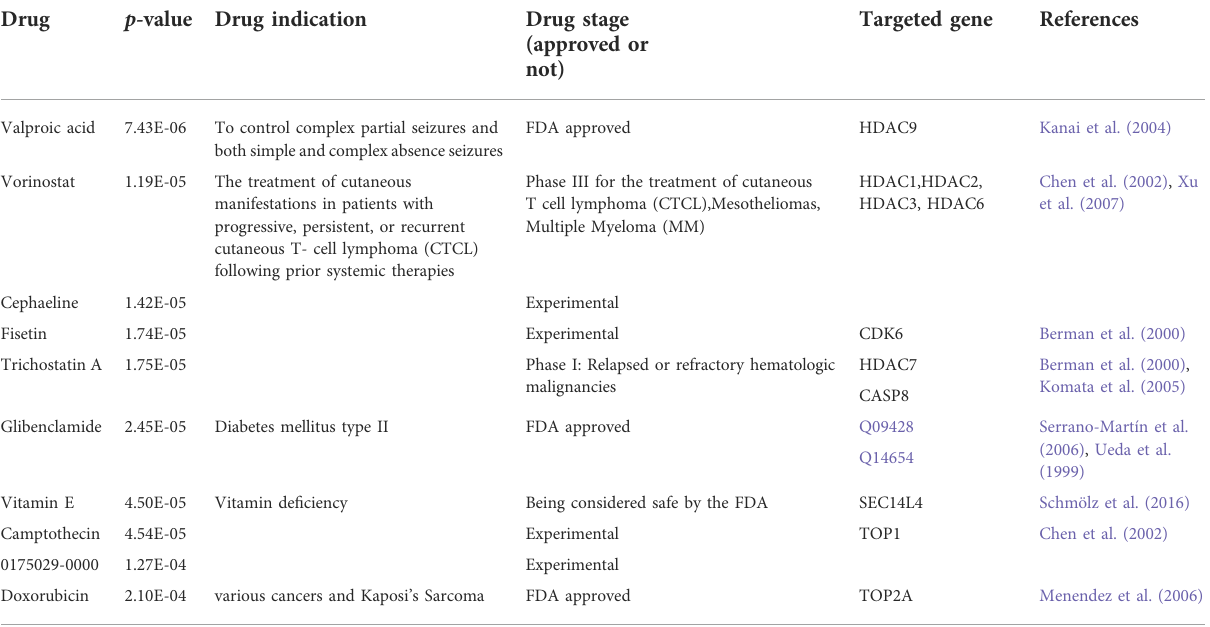
TABLE 1 List of the suggested drugs for PCa patients with PNN expression. Drug p -value Drug